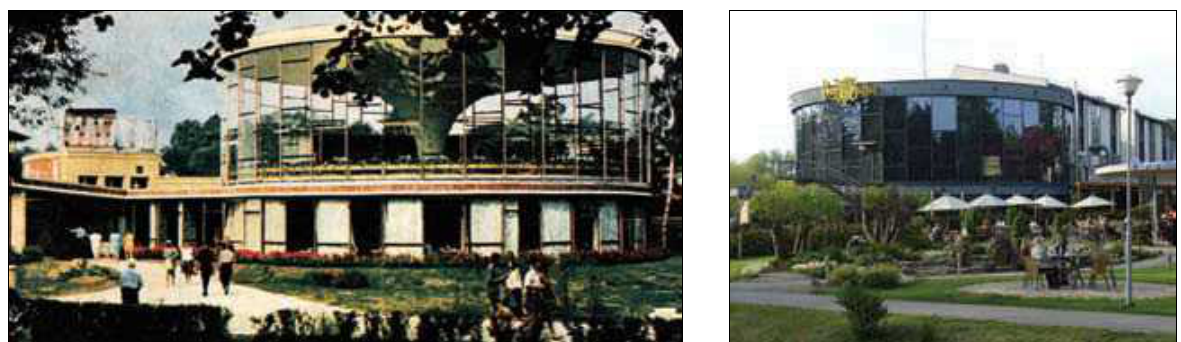
9, 10 pav. r­estoranas „Vasara“ Palangoje (arch. a­. eigirdas) 1964 m. ir dabar (9 pav. paimtas iš Švytu­rys, 1966 m. gegu­žės 9 d.; 10 pav. nu­otrau­ka a­. Gabrėno) Figs. 9, 10. r­estau­rant “Vasara“ in Palanga (arch. a­. eigirdas) in 1964 m. and nowadays